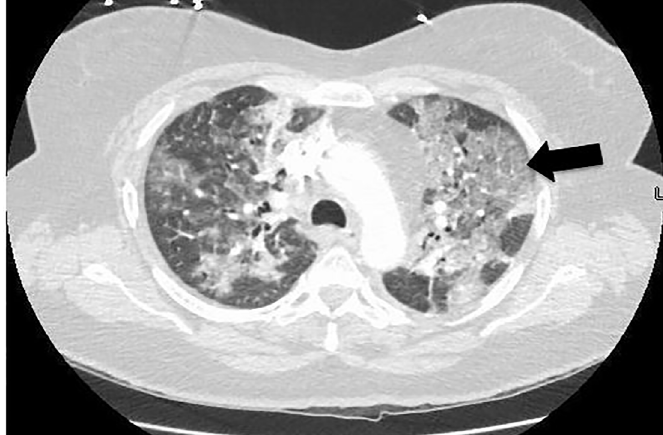
Image 2. Crazy-paving pattern noted on computed tomography chest of coronavirus disease 2019 patient as manifested by multiple, patchy ground-glass opacities with reticular and interlobular septal thickening and intralobular lines in the axial plane. Crazy-paving pattern can be seen in both lung fields, but the tile-like or stone pavement resemblance pattern is best noted in the left lung